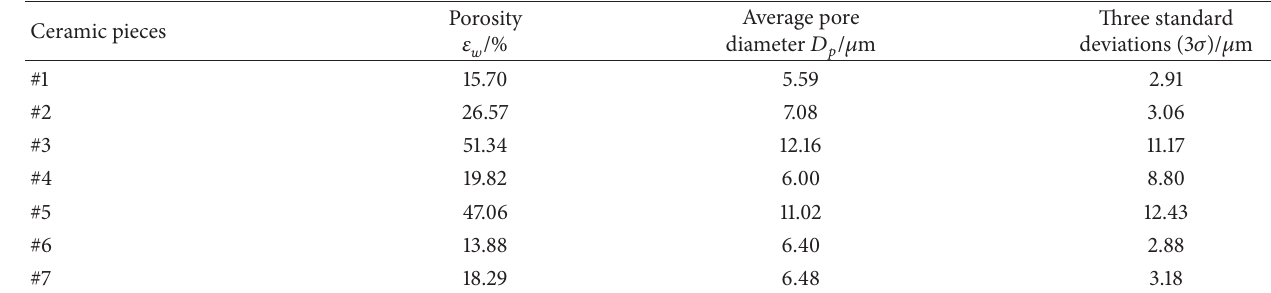
Table 2: Filter pore structures.